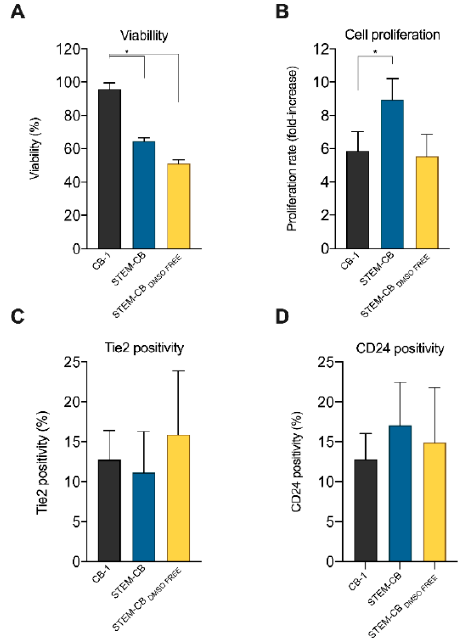
Figure 5. Cells ( n = 3) were suspended in CellBanker-1 (CB-1), STEM-CELLBANKER (STEM-CB), or STEM-CELLBANKER without DMSO (STEM-CB DMSO FREE ) and kept for on ice for 3 h and frozen for 1 day. Subsequently ( A ) cell viability was assessed. Following cryostorage and thawing cells were seeded cultured for 5 days. The ( B ) fold-increase in cell numbers was analyzed, as well as the fraction of ( C ) Tie2 expressing and ( D ) CD24 expressing cells as analyzed by flow cytometry. Data is presented as mean values with error bars presenting standard deviation. * p < 0.05.